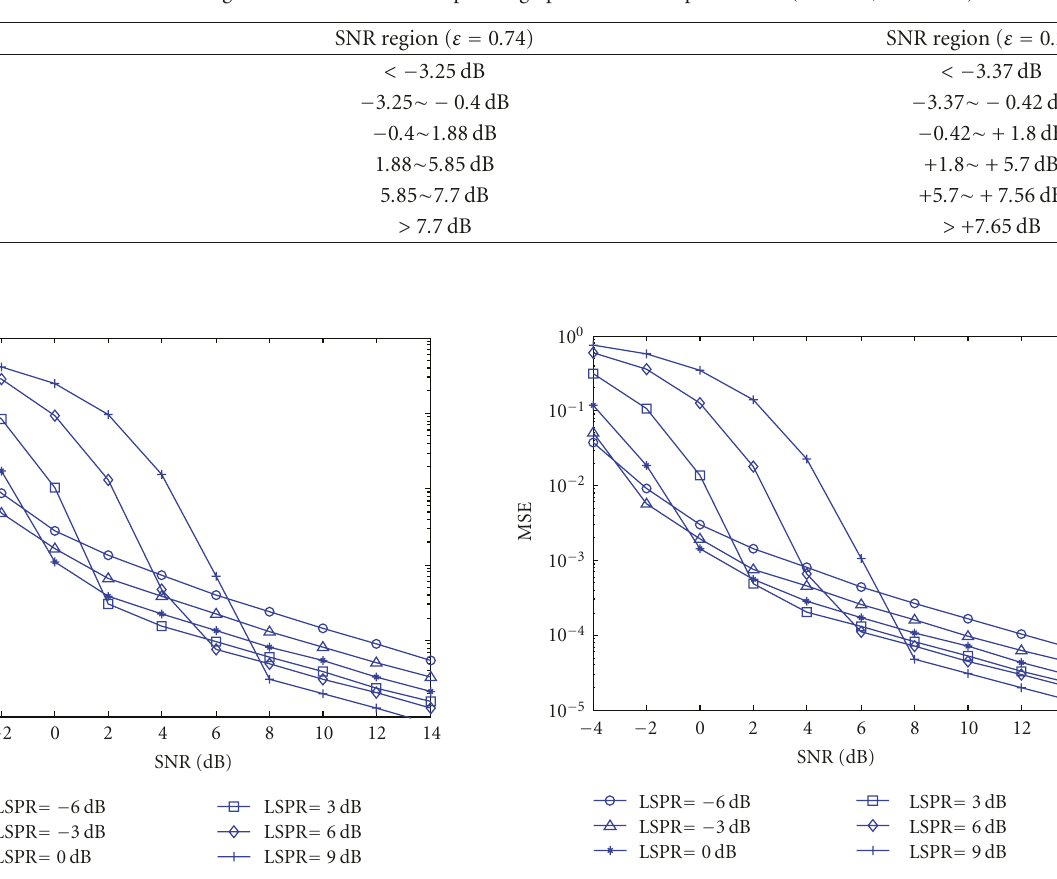
Figure 13: MSE performance of the proposed scheme ( ε = 0 . 246).